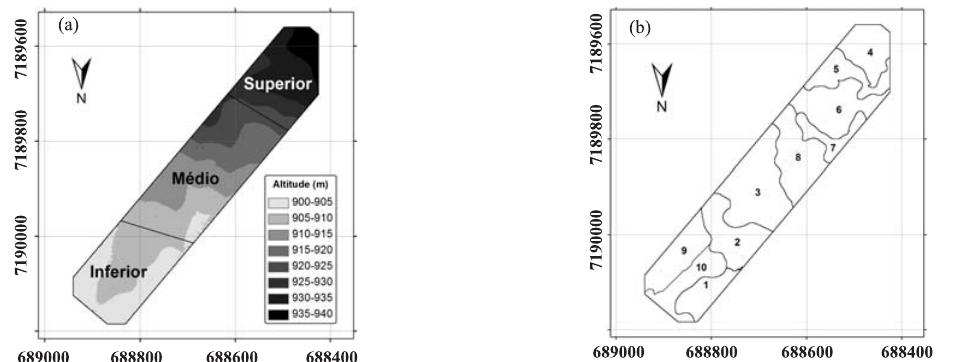
Figura 1. (a) Altitudes da área de estudo e subdivisões por geomorfologia e uso atual: inferior, médio